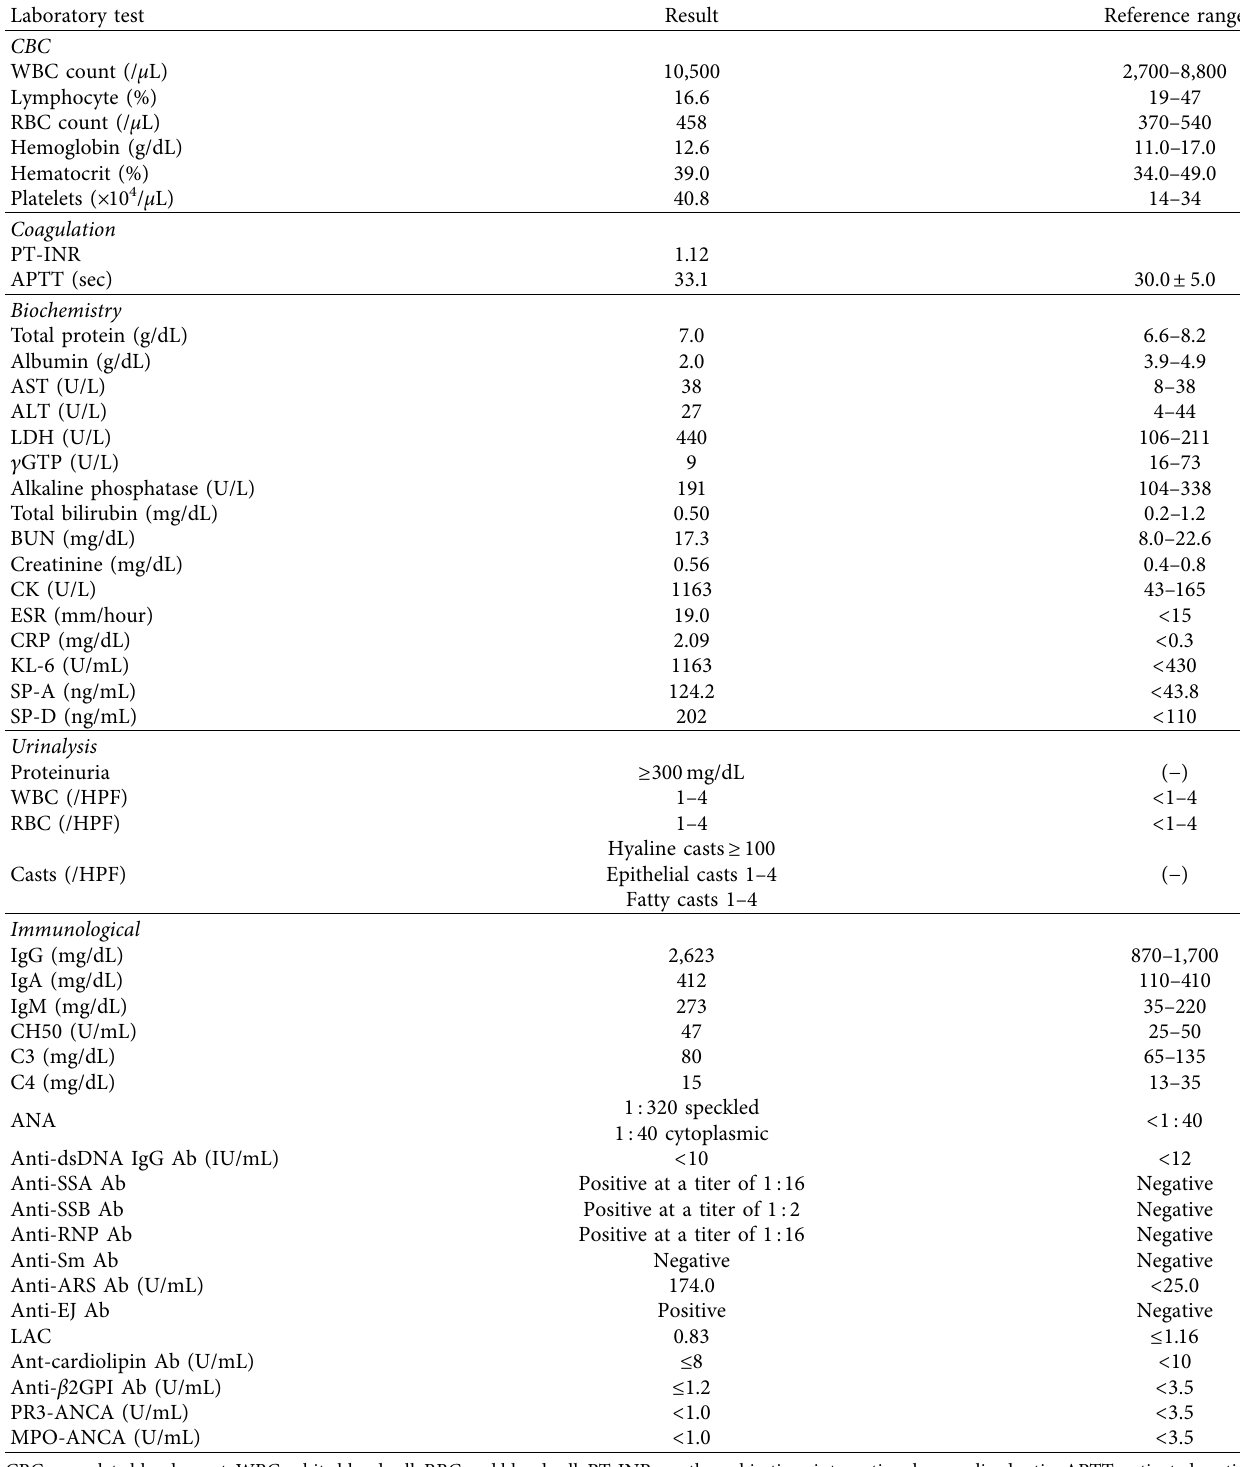
Table 1: Laboratory values on second admission of a woman with limited cutaneous systemic sclerosis who developed nephrotic